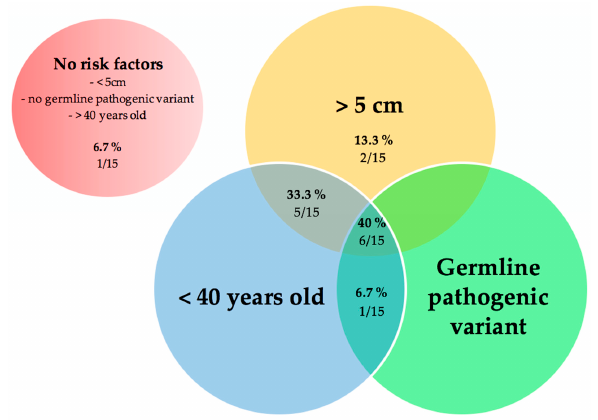
Figure 5. Venn diagram according to known risk factors for recurrent PHEOs/TAPGLs. Notes: recurrent PHEOs/TAPGLs for whom information for size, age at diagnosis, and genetic status was known ( n = 15). PHEOs: pheochromocytomas, TAPGLs: thoracoabdominal paragangliomas . Overall, 46.2% of the recurrences were local and 53.8% were metastatic. PHEOs had metastatic recurrences in 75% of cases compared to 15.4% in HNPGLs and 66.7% in